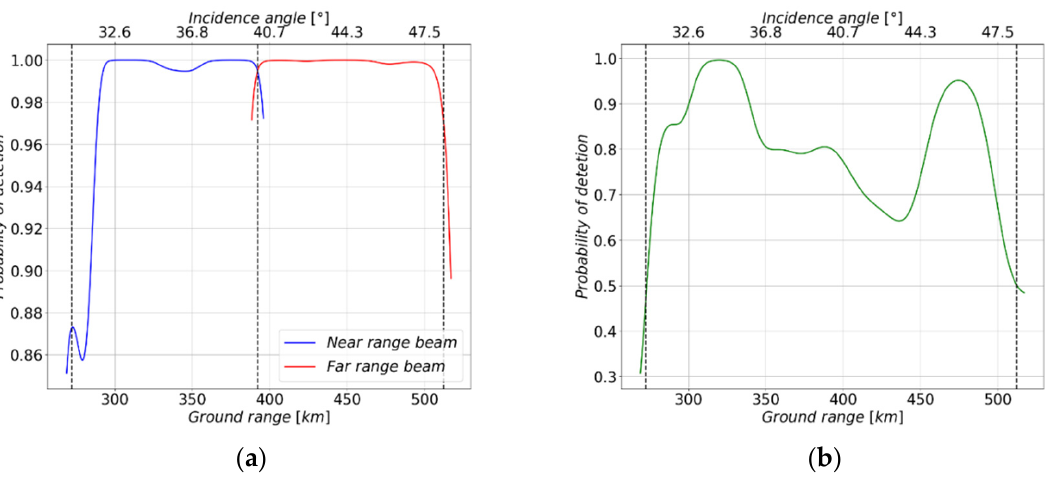
low PRF ambiguous mode are not taken into account here. Figure 5. Probability of detection of a small ship of 21 m × 6 m size ( a ) for the near range beam (blue curve) and far range beam (red curve), which cover a 120 km ground swath each, and ( b ) for the beam, which covers a 240 km ground swath. The 120 km ground swaths and the 240 km ground swath are highlighted.